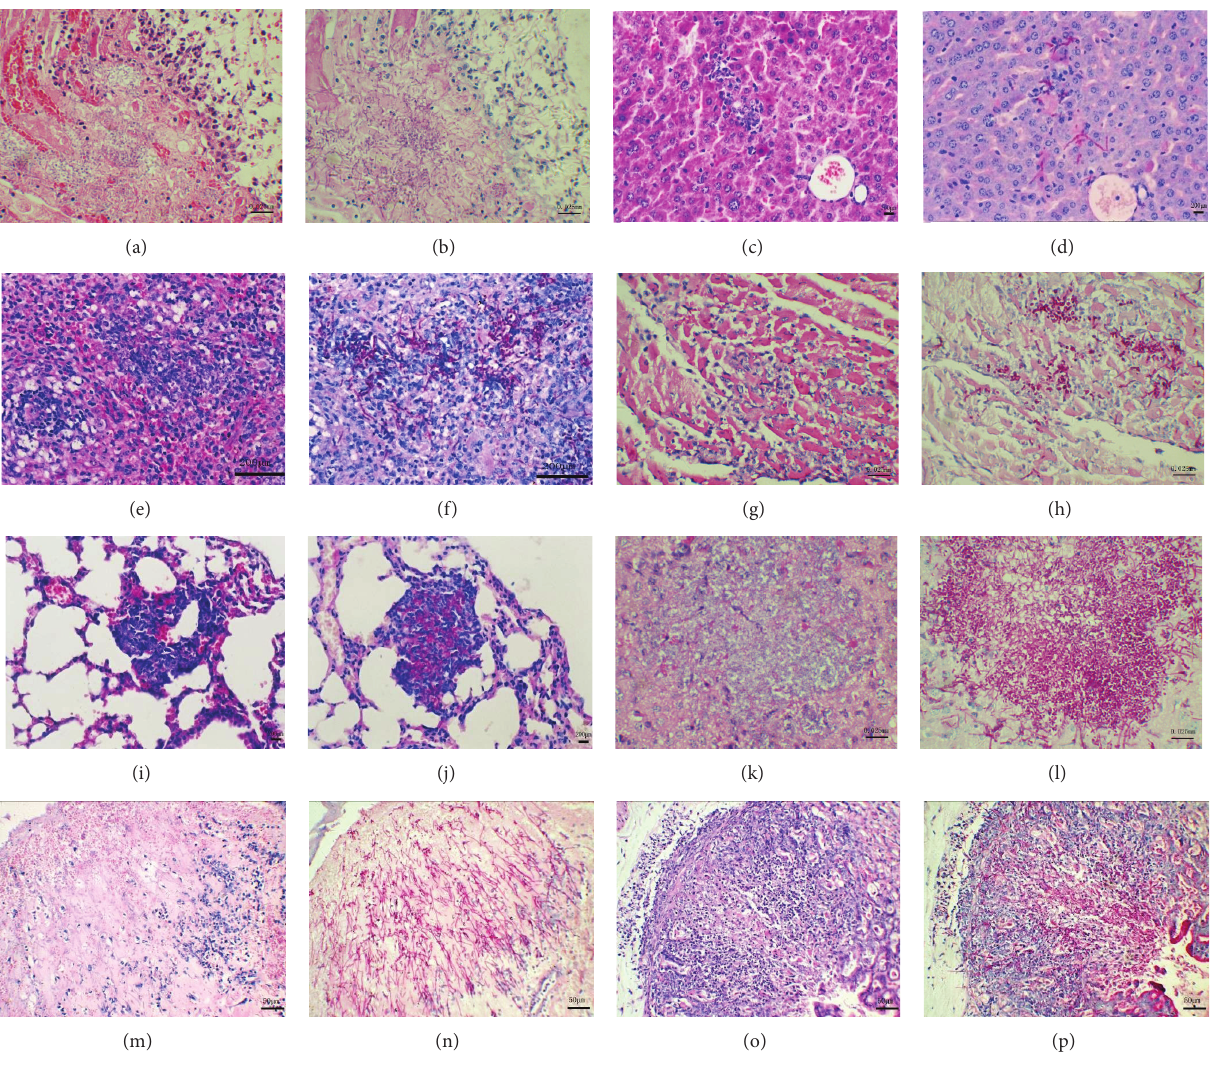
Figure 5: Histological findings of infected immunosuppressed mice. Figures 5(a), (c), (e), (g), (i), (k), (m), and (o) were H&E stained sections displaying the representative lesions in kidney, liver, spleen, heart, lung, brain, stomach, and bladder walls, respectively. Figures 5(b), (d), (f), (h), (j), (l), (n), and (p) stained by PAS showed fungal mycelia infiltration in kidney, liver, spleen, heart, lung, brain, stomach, and bladder walls,